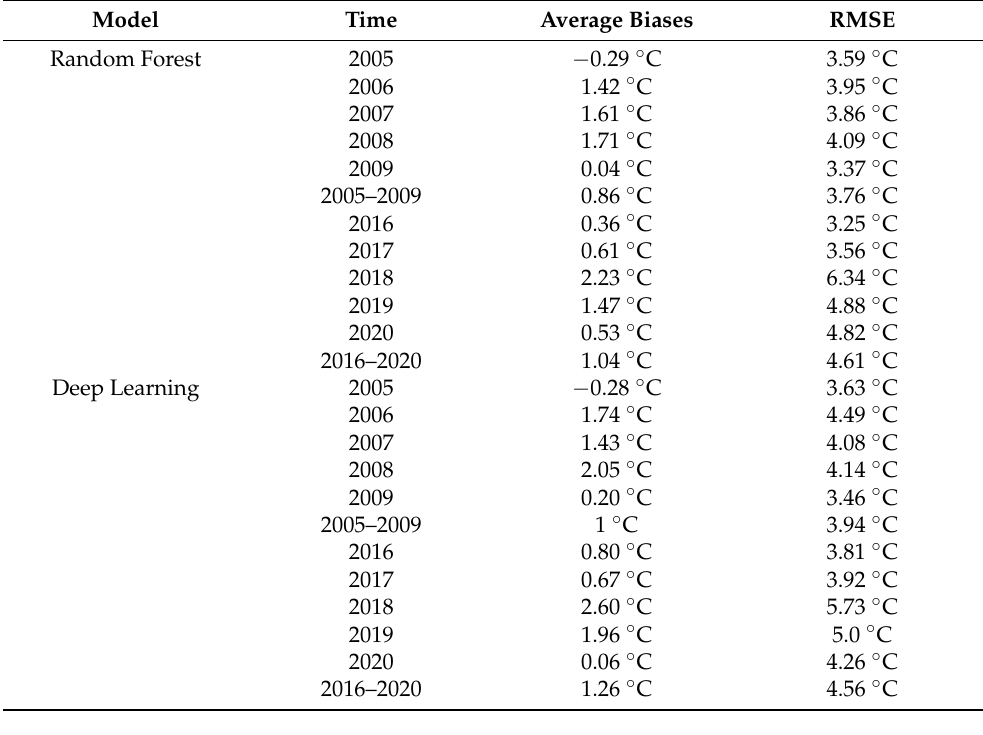
Table 5. Accuracy of the simulated data.